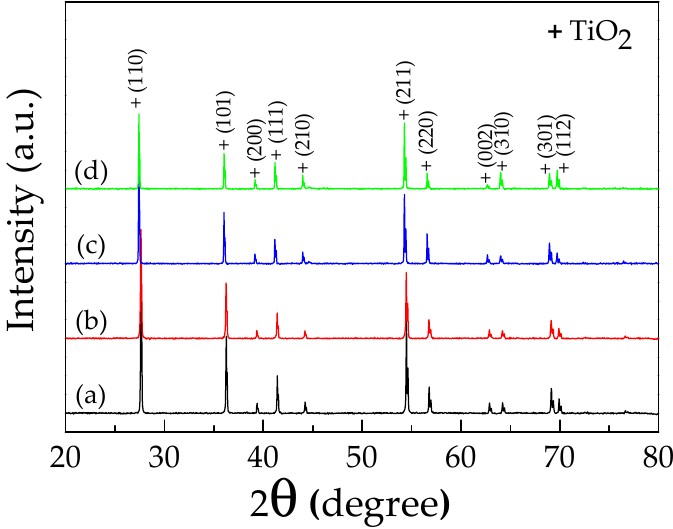
Figure 1. XRD patterns of: ( a ) 0.5% CoNTO; ( b ) 1% CoNTO powders and sintered ceramics; ( c ) 0.5% CoNTO; and ( d ) 1% CoNTO ceramics. Table 1. Lattice parameters of (Co 0.33 Nb 0.67 ) x Ti 1- x O 2 powders and ceramics. Lattice Parameter Sample